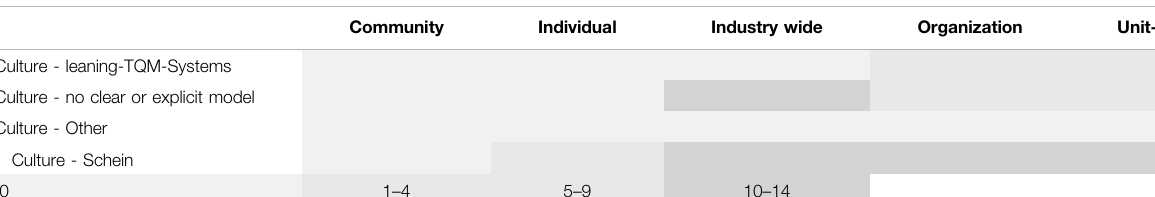
TABLE 3 | Matrix query results: Culture by unit of analysis.